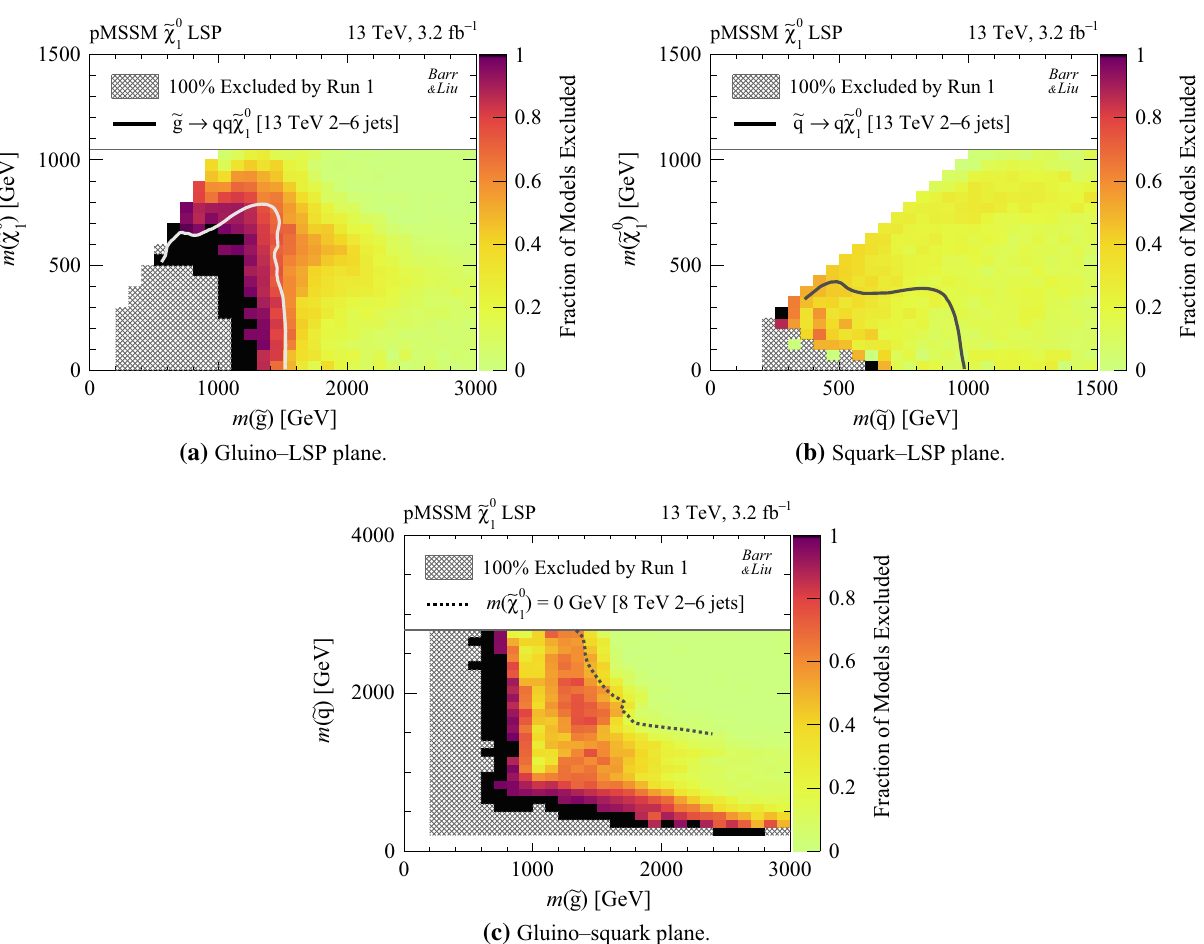
Fig. 11 Fractionofmodelpointsexcludedbythecombinedconstraints being produced by ATLAS due to prior non-LHC constraints. Hatched grey regions indicate bins where all points were excluded by Run 1 in from the six early 13 TeV searches considered in Table 1, out of the points that survived Run 1 constraints. In each mass bin, the colour Ref. [53]. Overlayed grey solid lines are the simplified model limits scale denotes the fraction of points excluded at 95% confidence level ( upper left ) from the 13 TeV 2–6 jets search [1] for gluinos ˜ g → qq ˜ χ 0 1 normalised to the number of points satisfying ‘without long-lived’ in and squarks ˜ q → q ˜ χ 0 ( upper right ). In the latter case, all eight squarks 1 Table 3, where black indicates 100% exclusion. This is projected into are of the first two generations and assumed to be mass-degenerate. For the mass planes of the gluino–LSP ˜ g – ˜ χ 0 ( upper left ) and squark–LSP thegluino–squark plane( lower ), theoverlayedgreydashedlineistaken 1 ˜ q – ˜ χ 0 from the ‘gluino–squark–LSP simplified pMSSM’ scenario from the 8 ( upper right ). Here, m ( ˜ q ) is the mass of the lightest squark 1 TeV 2–6 jets search among the first two generations. White regions correspond to no models